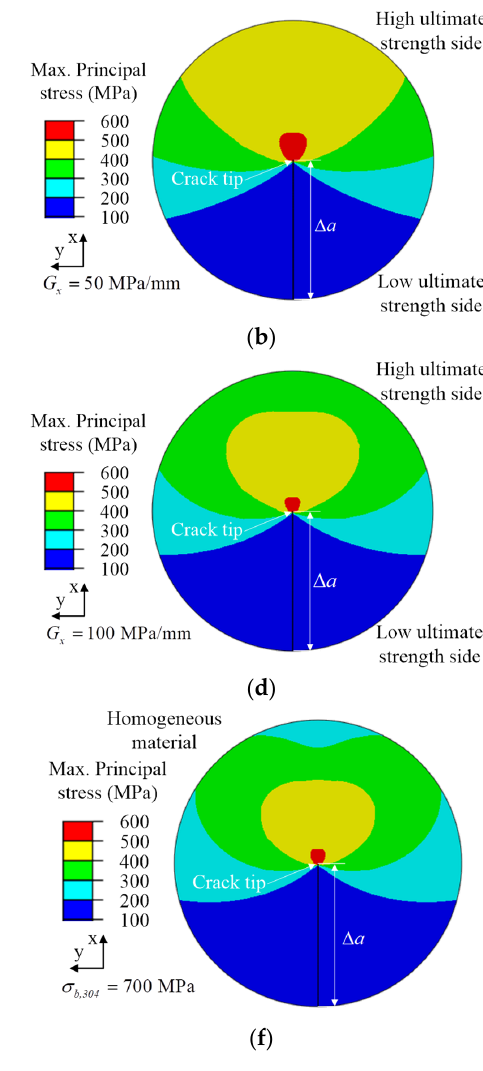
Figure 12. Maximum principal stress field of the crack tip with different ultimate strength mismatch coefficients of crack propagation length ∆ a = 0.6 mm in the x-direction. ( a ) G x = − 50 MPa/mm, ( b ) G x = 50 MPa/mm, ( c ) G x = − 100 MPa/mm, ( d ) G x = 100 MPa/mm, ( e ) σ b,316L = 600 MPa, ( f ) σ b,304 = 700